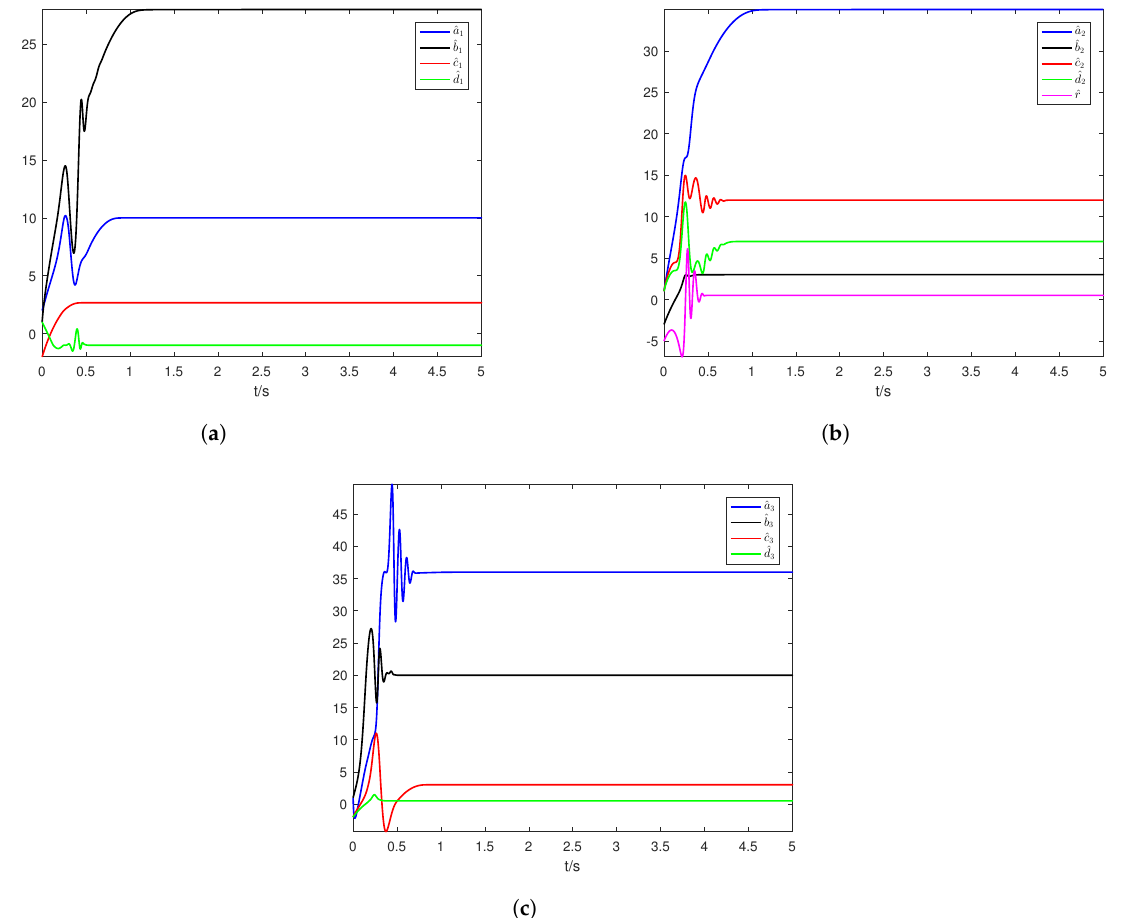
Figure 8. The estimation of parameters ˆ a 1 , ˆ b 1 , ˆ c 1 , ˆ d 1 of drive system (31) ( a ), ˆ a 2 , ˆ b 2 , ˆ c 2 , ˆ d 2 , ˆ r of drive